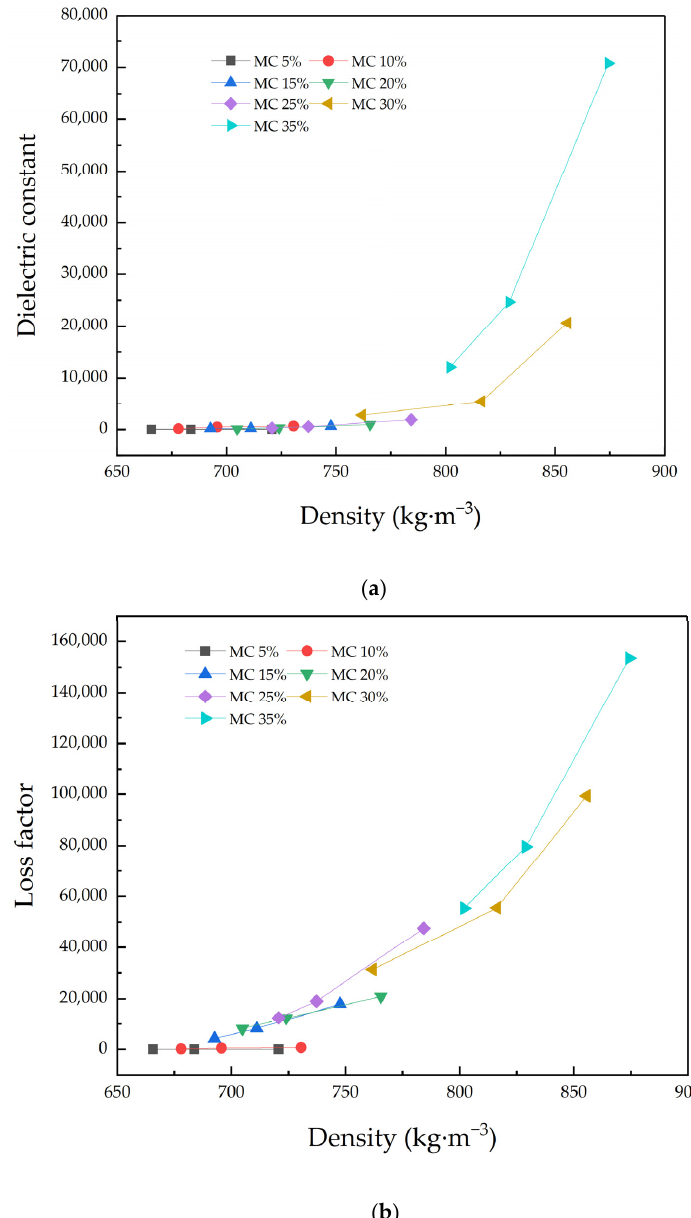
Figure 7. Bulk density dependence of dielectric properties at various moisture contents: ( a ) dielectric constant, ( b ) loss factor. Table 1. Bulk density values of samples at various moisture contents.